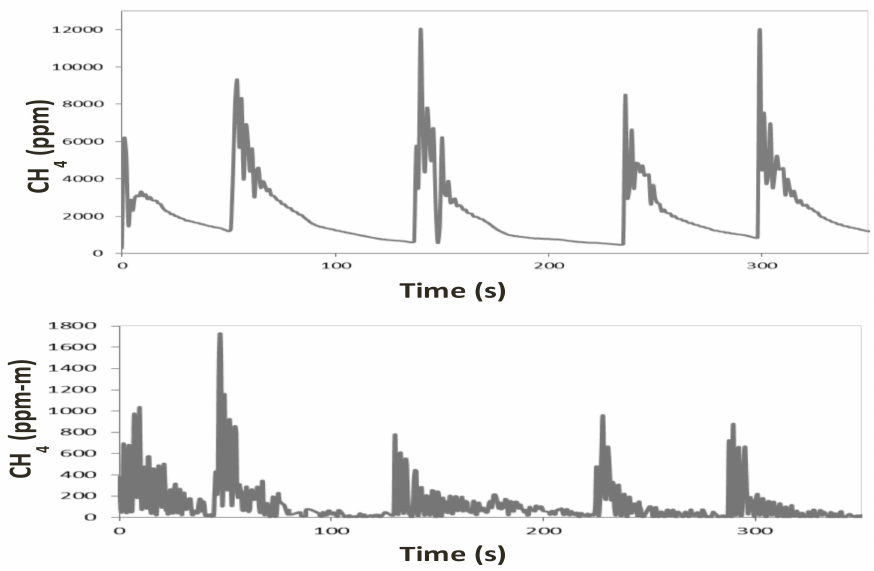
Figure 1. Representation of CH 4 concentration for a cow measured with a non-dispersive infrared (NDIR) sensor (above), and laser methane detector (LMD; below) with di ff erent belching